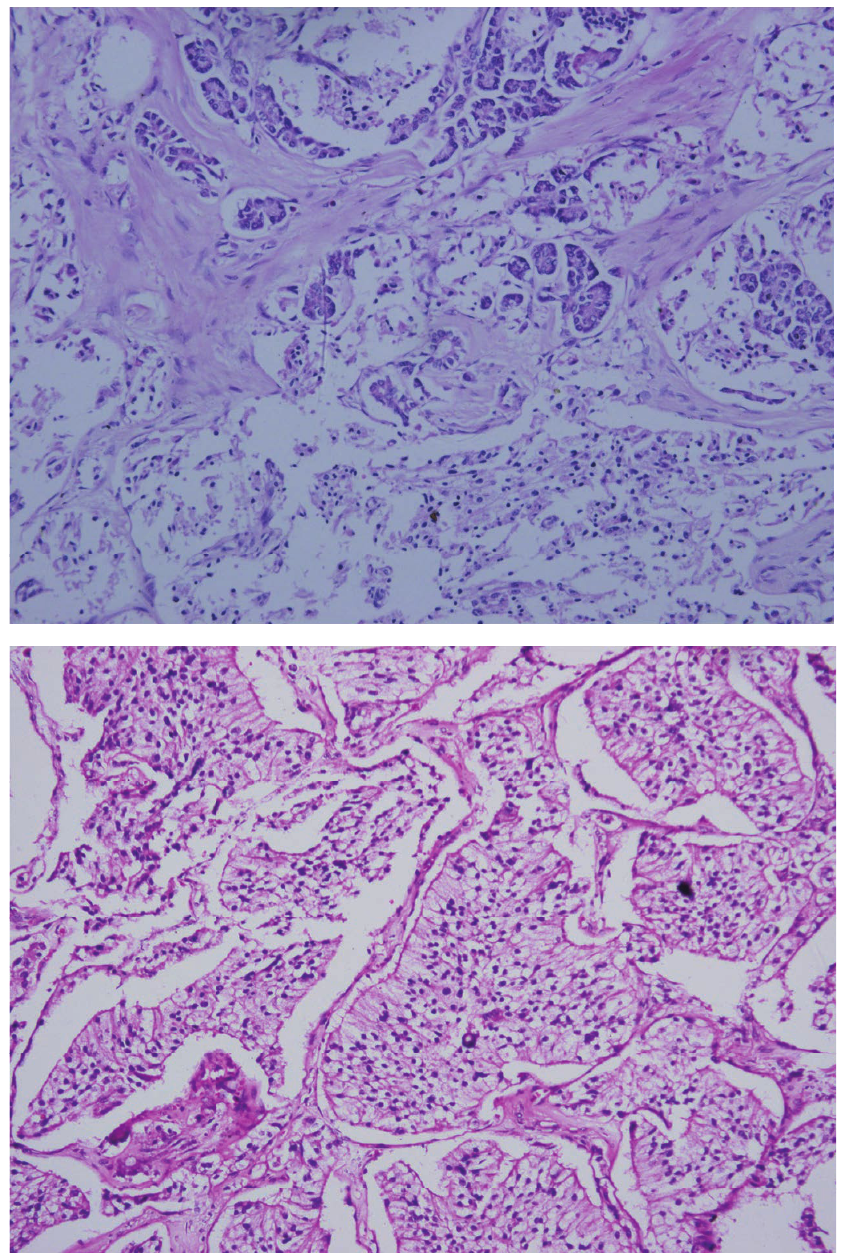
Figure 2: The upper histopathological slide shows the invasive front of the tumor traversing and dissecting through pancreatic acini. The lower slide shows the tall columnar clear tumor cells forming trabecula and nests with small punctate